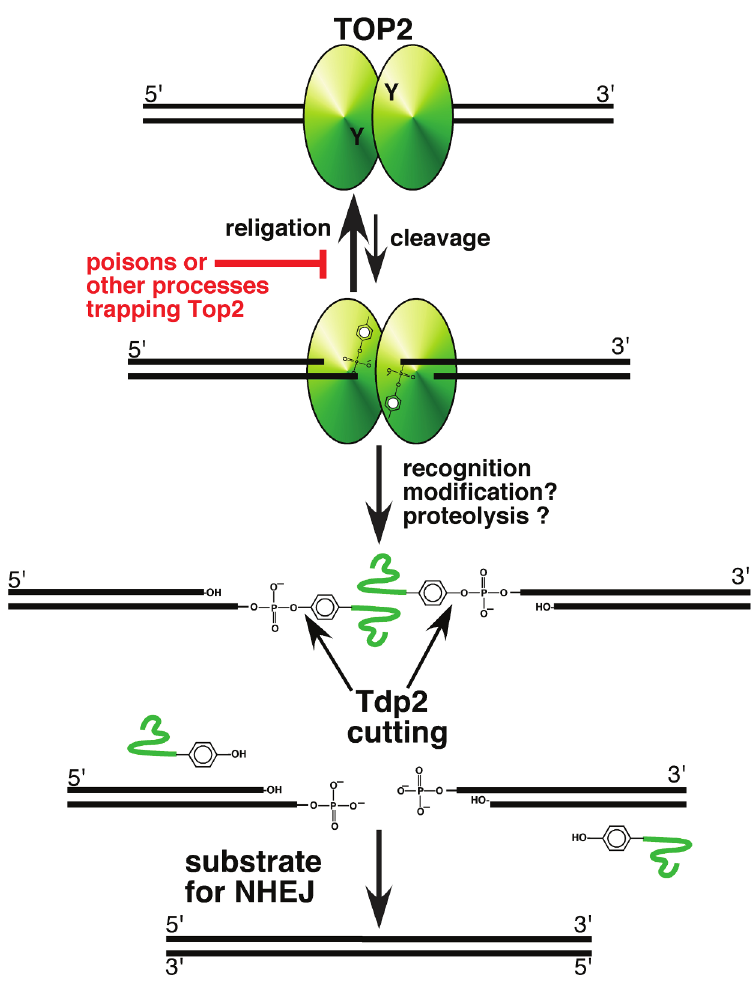
Figure 1. A pathway for repairing topoisomerase II–mediated DNA damage. Topoisomerase II, a homodimeric protein, cleaves both strands of DNA, and generates a four base overhang. In the absence of perturbation (such as topoisomerase poisons), religation of the broken strands is kinetically favored, and is likely inhibited by topoisomerase poisons. Recognition of the trapped protein may trigger modification and proteolysis, leaving a short peptide covalently bound to DNA. This peptide can be removed by Tdp2 cleavage of the tyrosyl phosphate bond, leaving DNA with a double-strand break. If the broken DNA is not processed prior to ligation, e.g., by DNA ligase IV in the NHEJ pathway, the result will be error-free repair of the trapped covalent complex.